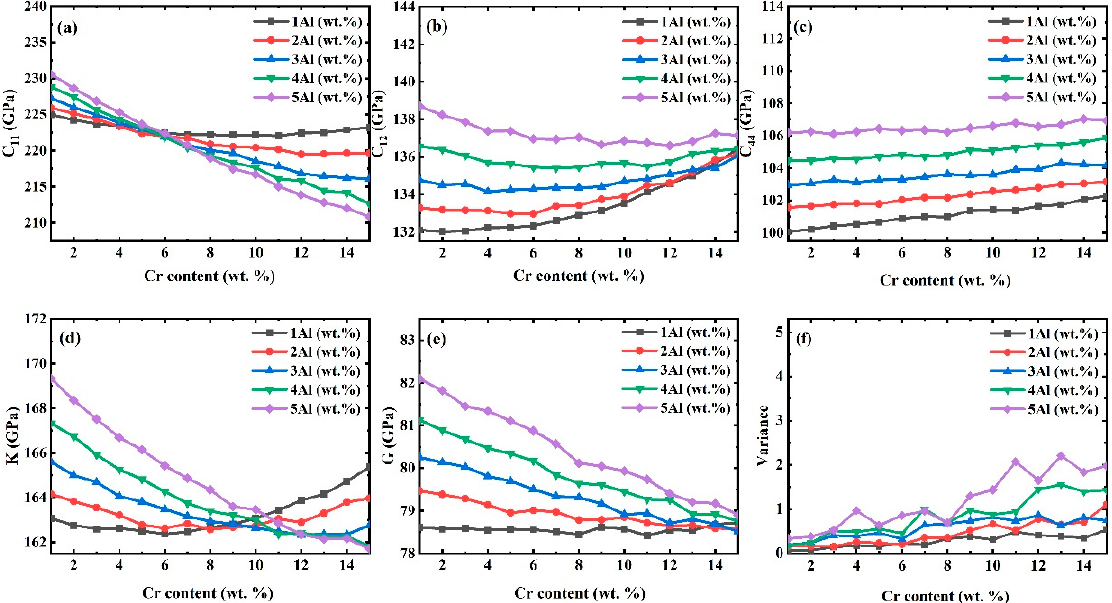
Figure 2. ( a )–( e ) Dependence of elastic constants, C 11 , C 12 , C 44 , bulk modulus and shear modulus on Cr and Al concentration at 300 k. ( f ) Example of statistical uncertainty for these elastic constants based on 50 simulations.